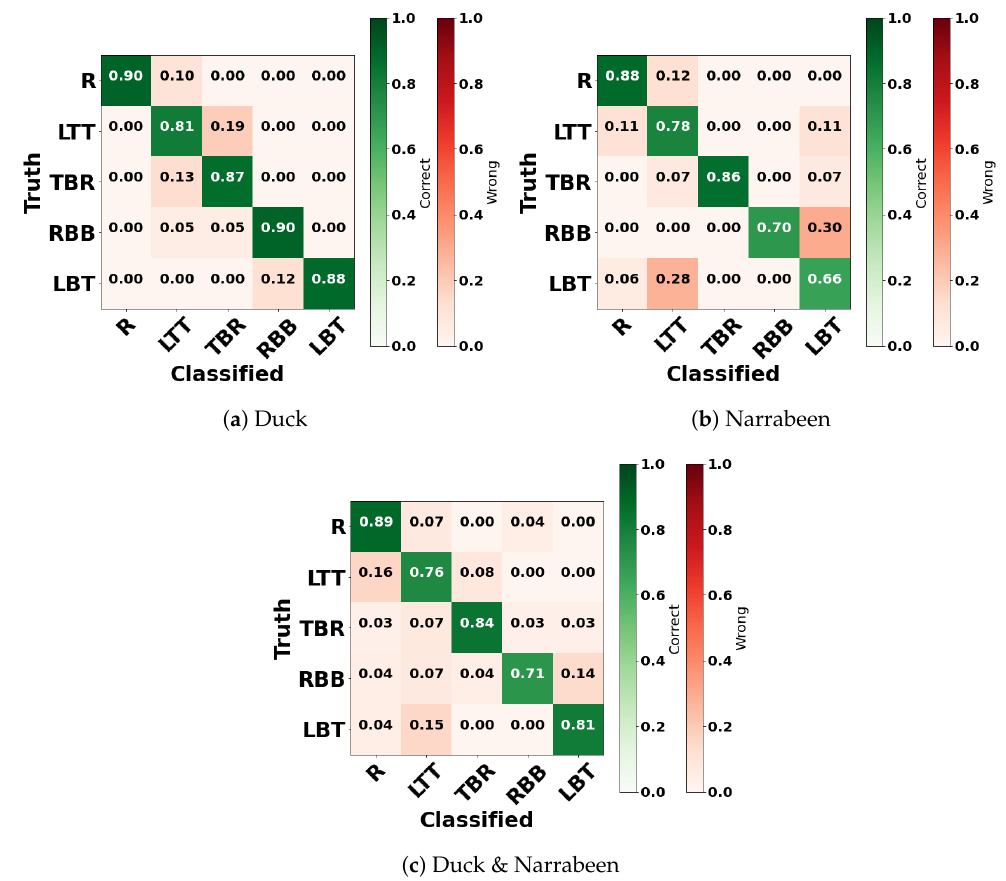
Figure 9. Normalized confusion matrices for the CombinedSINGLE-CNN tests at ( a ) Duck and ( b ) Narrabeen and ( c ) on the test data of Duck and Narrabeen